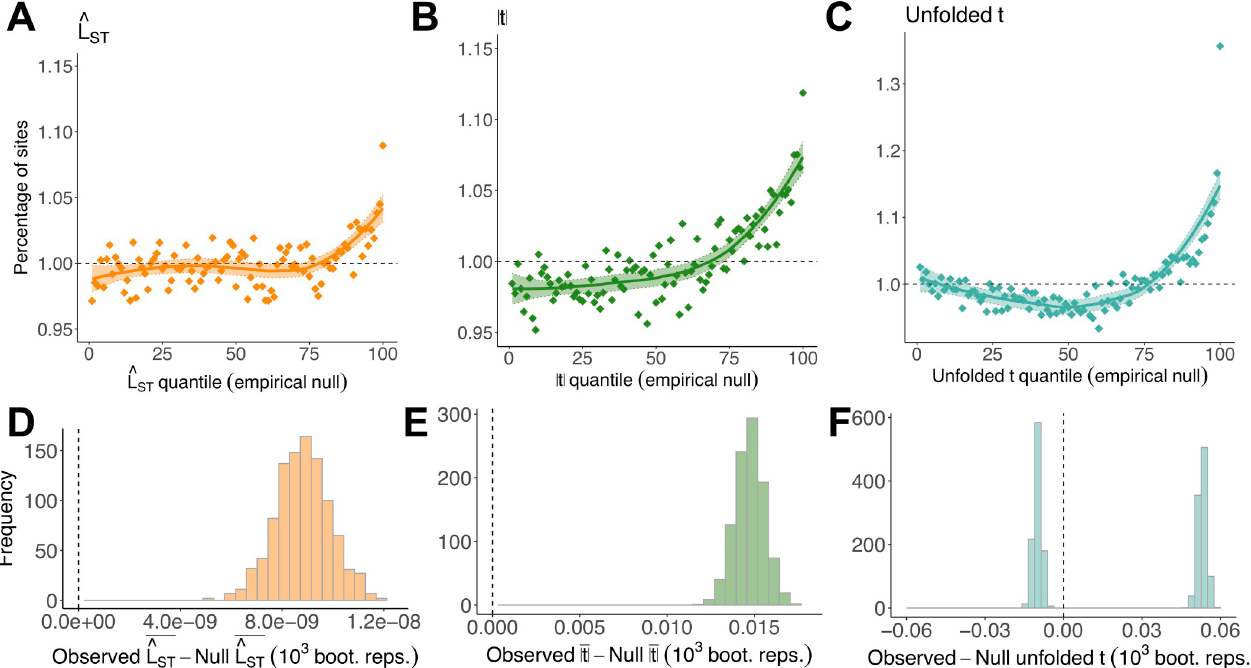
Fig 4. Structure-corrected metrics reaffirm ^ F -based signals of sex-differential selection. ( A–C ) Percentage of sites falling into each of 100 quantiles of the ST empirical null distributions of ^ L , | t |, and unfolded t . In the absence of sex differences in selection, approximately 1% of observed SNPs should fall into each ST quantile of the null (dashed line). LOESS curves ( ± SE) are presented for visual emphasis. ( D–F ) Difference between the mean of each metric in observed and empirical null data across 1,000 bootstrap replicates. Vertical line intersects zero (no difference between observed and null data). For unfolded t , differences between observed and null data were obtained separately for negative and positive values. This illustrates that there is enrichment of SNPs in both tails of the null. The code and data needed to generate this figure can be found at https://github.com/filipluca/polygenic_SA_selection_in_the_UK_biobank and https:// zenodo.org/record/6824671. SNP, single-nucleotide polymorphism.